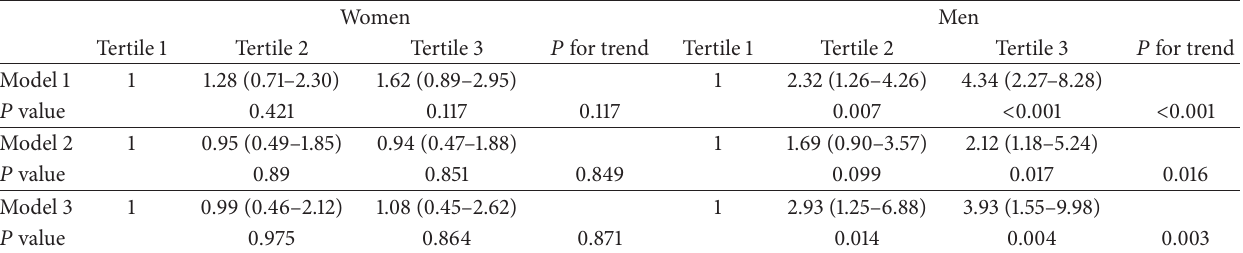
Table 3: The risk of prevalent NAFLD according to tertiles of